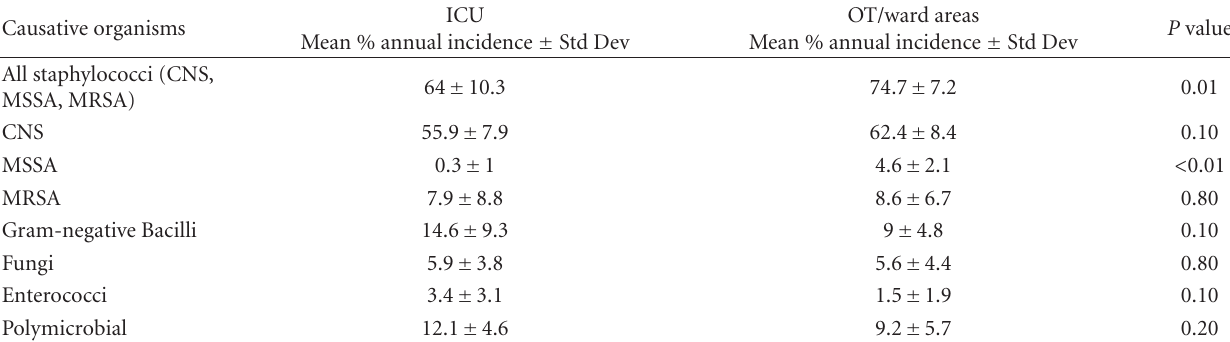
Table 4: Culture-positive CVCs by category of isolated organism comparison of critical care and ward areas. Causative